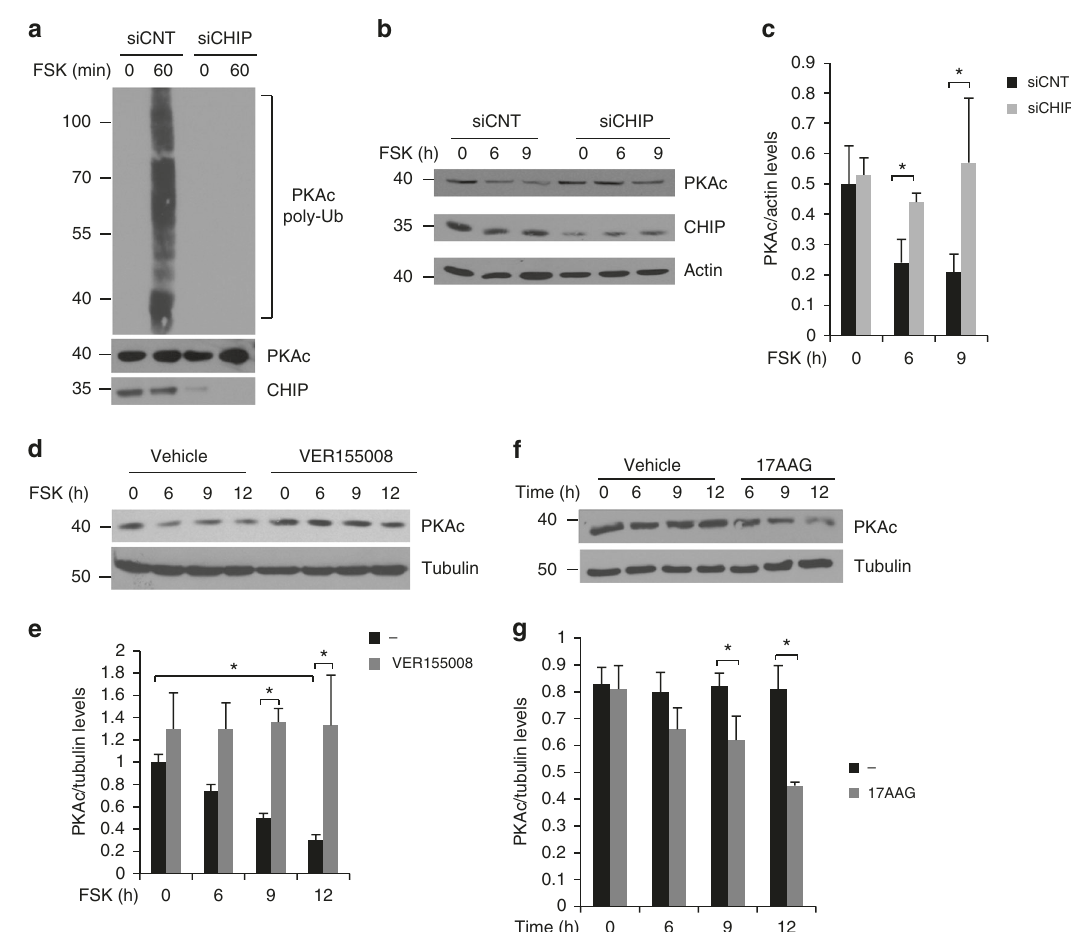
Fig. 4 CHIP ubiquitylates PKAc. a Lysates from cells transiently transfected with HA-ubiquitin and siRNAs (control or siRNA targeting CHIP), left untreated or stimulated with FSK, were immunoprecipitated with anti-PKAc. The precipitates were immunoblotted with anti-PKAc and anti-HA antibodies. b Cells transfected with siRNAs (control or siRNA targeting CHIP) were serum deprived overnight and treated with FSK. Lysates were immunoblotted with the indicated antibodies. c Quantitative analysis of the experiments shown in b . A mean value ± S.E.M. of three independent experiments is reported. Student ’ s t test, * p < 0.05. d Cells were stimulated with FSK, either in absence or presence of the HSP70 inhibitor (VER155008). Lysates were immunoblotted for PKAc and tubulin. e Quantitative analysis is shown. A mean value ± S.E.M. of three independent experiments is reported. Student ’ s t test, * p < 0.05. f Cells were untreated (vehicle) or treated with HSP90 inhibitor (17AAG) and harvested at the indicated times. Lysates were immunoblotted for PKAc and tubulin. g Quantitative analysis is shown. A mean value ± S.E.M. of three independent experiments is reported. Student ’ s t test, * p <